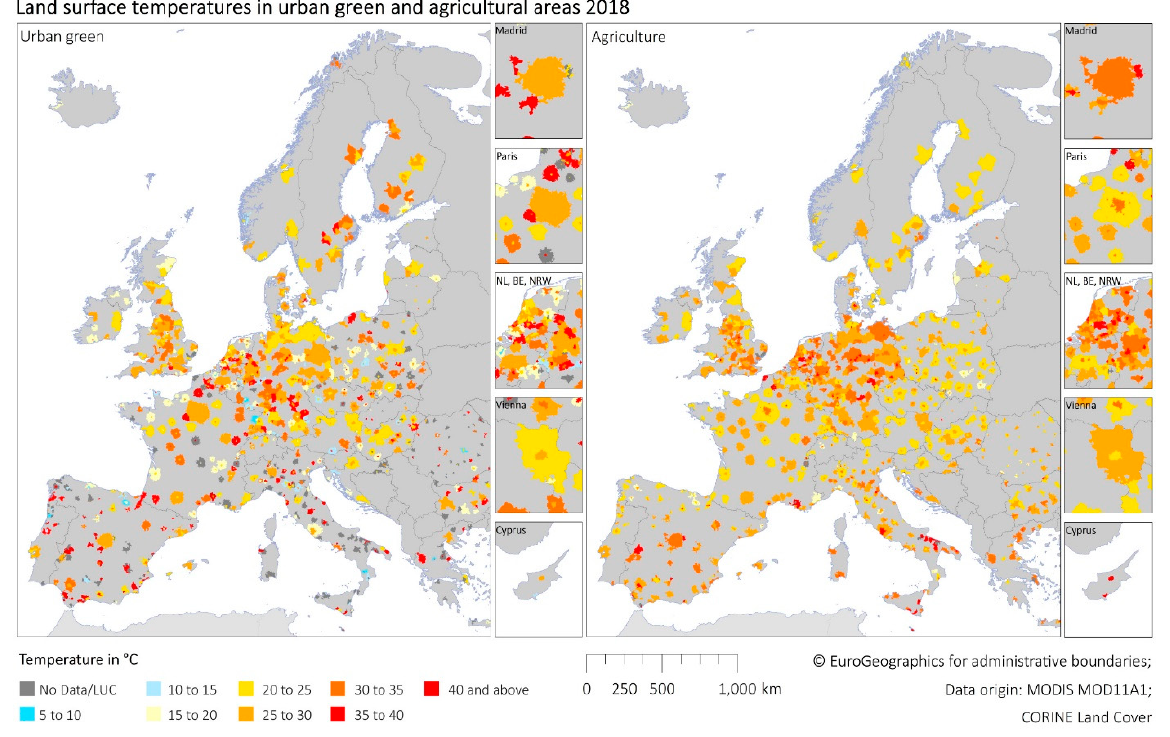
Figure 13. LST of urban green and agricultural areas, 2018.